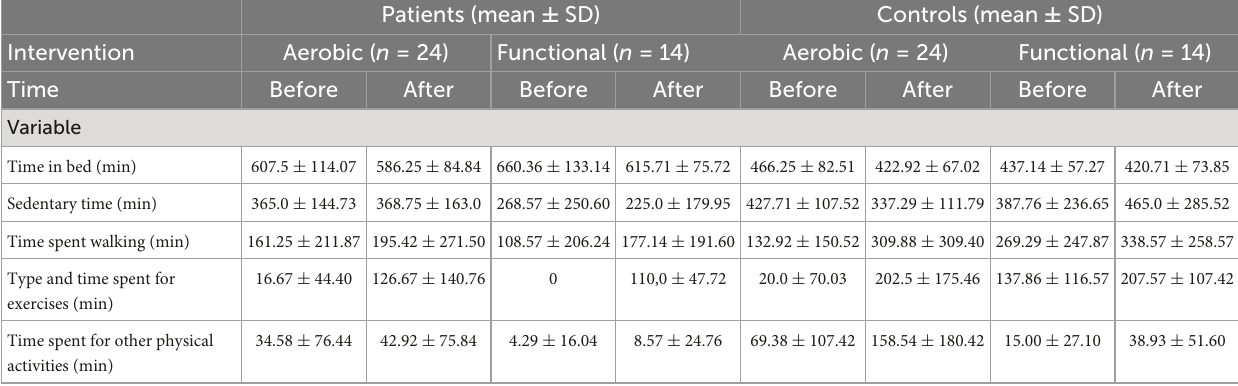
TABLE 4 Simple Physical Activity Questionnaire (SIMPAQ) assessment according to intervention.